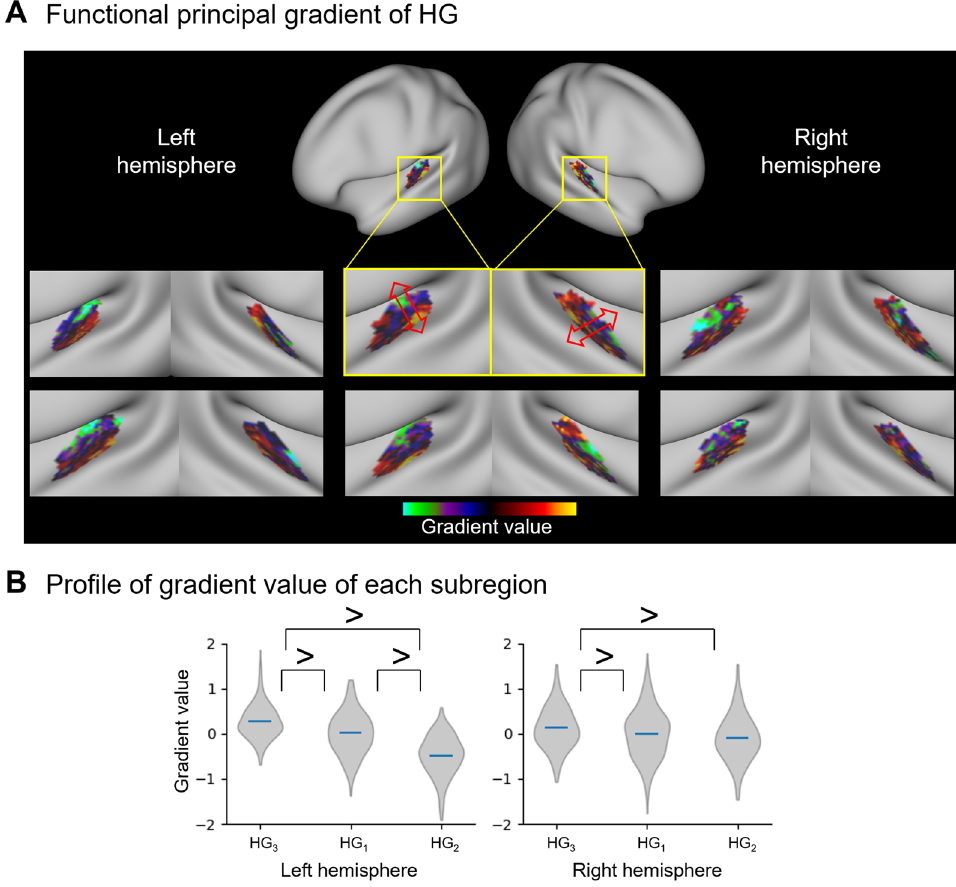
Figure 4. Functional gradient within the HG. ( A ) We assessed the principal gradient within the HG for six randomly selected participants. ( B ) We stratified the gradient value of each subregion, and the significant differences between subregion pairs are indicated by inequality